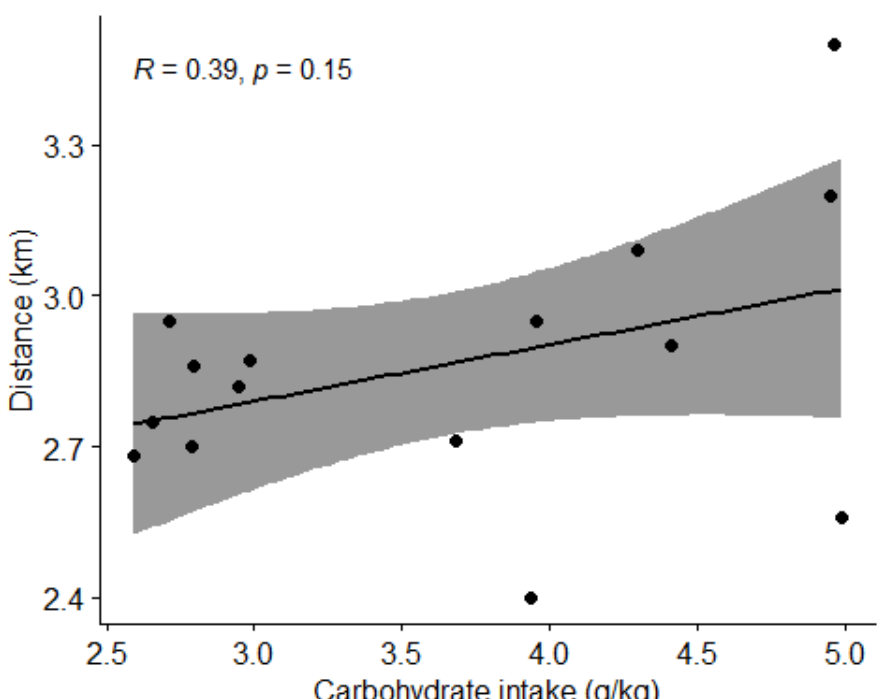
Figure 15. Correlation between carbohydrate intake and distance covered by subjects in the Cooper test. Dots represent individual participants ( n = 15). Grey shaded area indicates 95% CI.